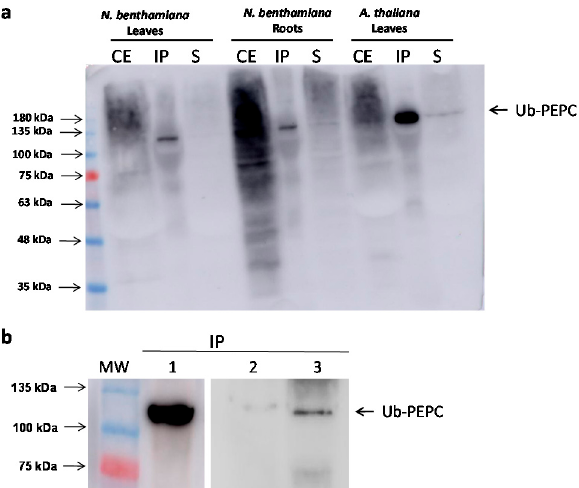
Figure 6. Monoubiquitinated PEPC is revealed by anti-Ubiquitin antibodies in immunoprecipitates. Crude extracts (CE) were obtained from different plant tissues (0.5 g/mL extraction buffer for leaves, and 1 g/mL extraction buffer for roots and cells) and PEPC contained in 3 mL of crude extracts was immunoprecipitated with anti-PEPC antibodies. Finally, immunoprecipitates were analyzed by immunoblotting and detected with anti-Ubiquitin antibodies. ( a ) PEPC immunoprecipitation from Nicothiana benthamiana leaves and roots and A. thaliana leaves. CE, 30 µg protein from crude extract; IP, immunoprecipitate; S, supernatant. ( b ) PEPC immunoprecipitated from extracts of A. thaliana leaves (lane 1), N. benthamiana cells (lane 2), and 3-MA-treated N. benthamiana cells (lane 3).